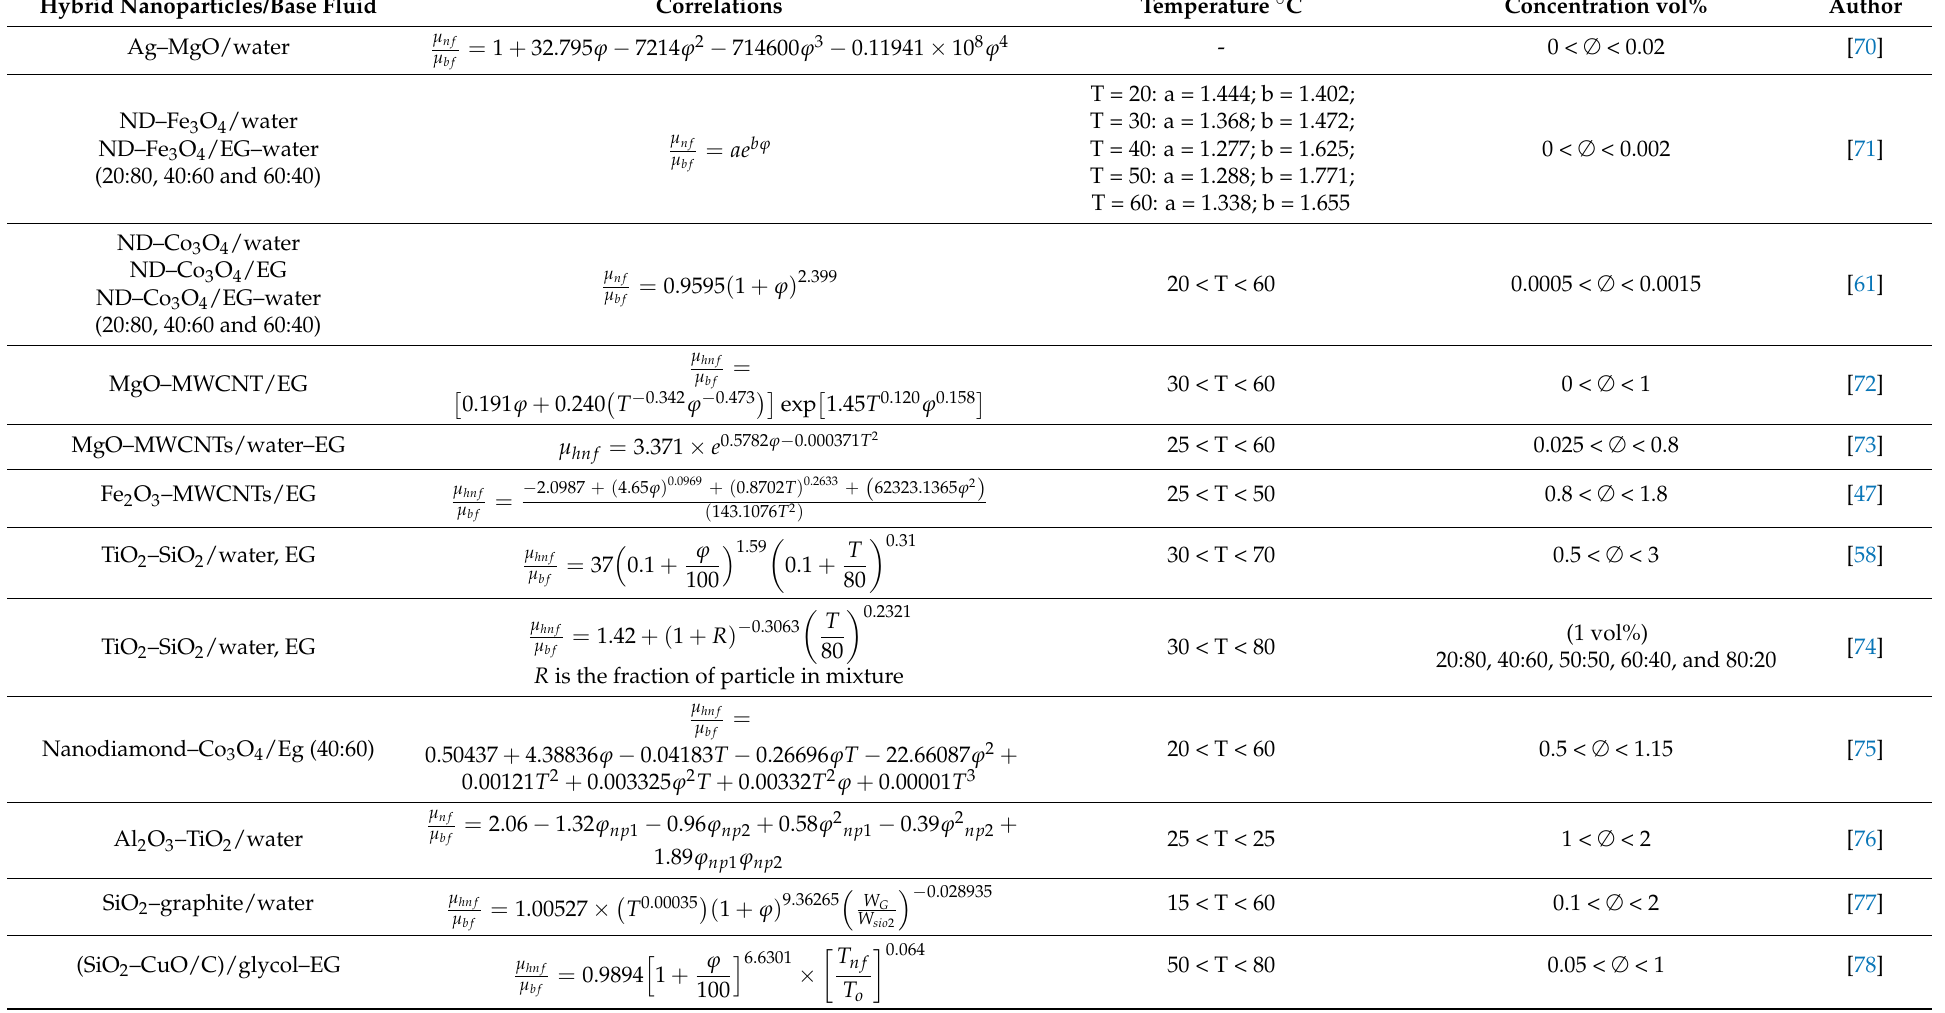
Table 3. Viscosity models for water and ethylene glycol-based hybrid